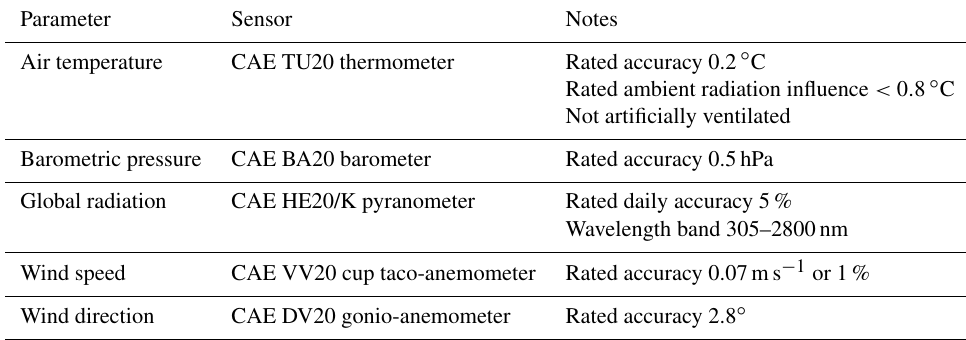
Table 1. Sensors installed at the CM AWS.